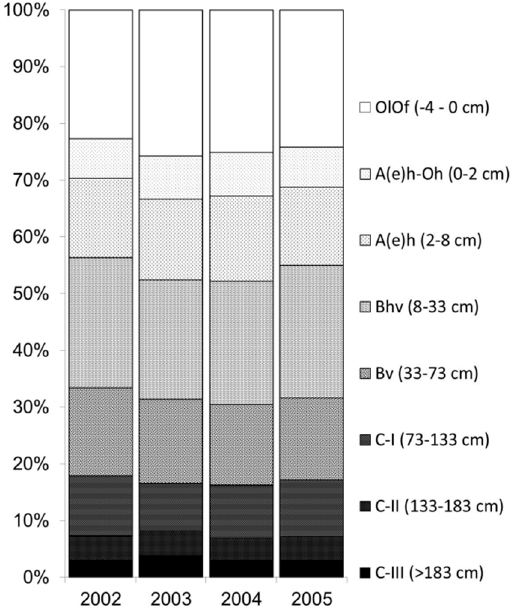
Figure 4. Vertical distribution of relative soil water uptake over four years, based on simulation results of the water budget.